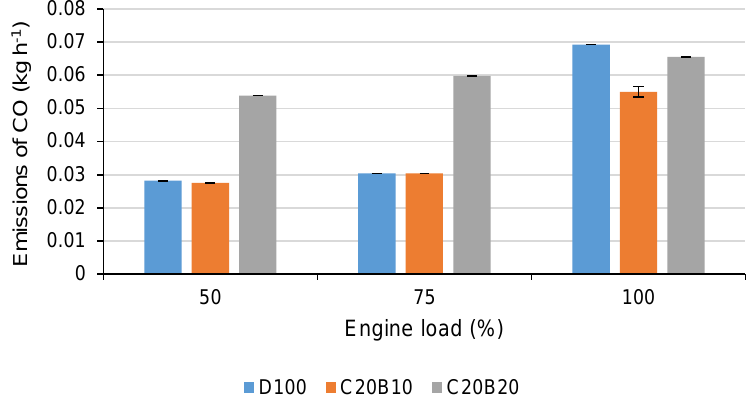
Figure 2. Emissions of CO in relation to engine load for all tested fuels (error bars represent the standard deviation).